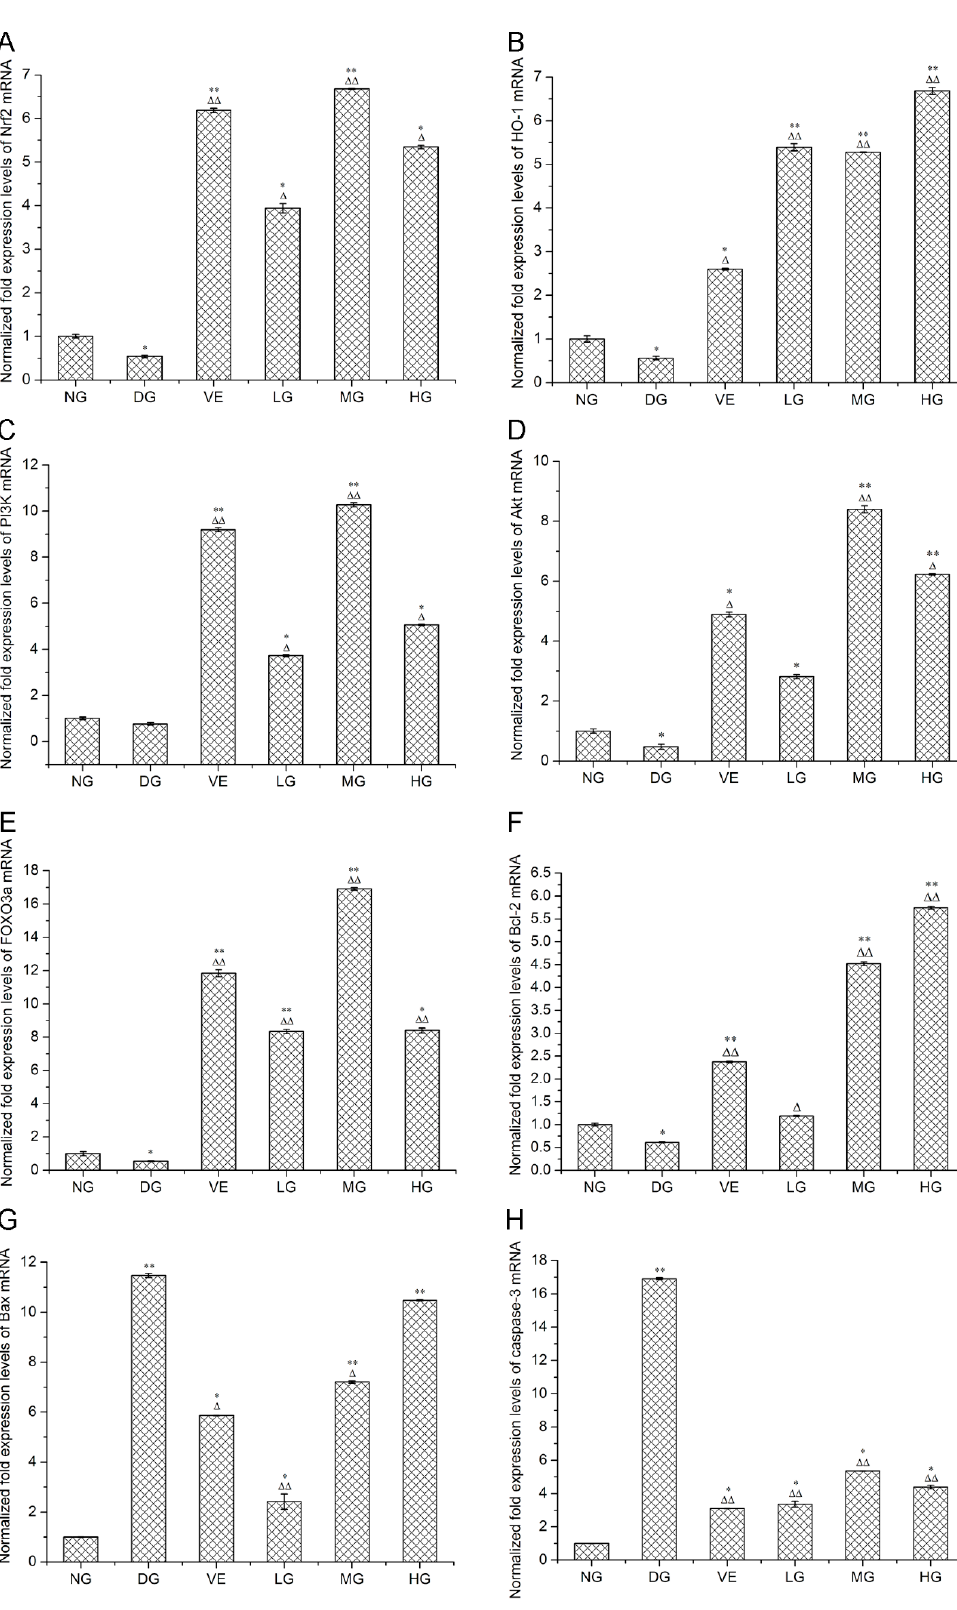
Figure 4. E ff ect of Athyrium multidentatum (Doll.) Ching (AMC) polysaccharides on ( A ) Nrf2 , ( B ) HO-1 , ( C ) PI3K , ( D ) Akt , ( E ) FOXO3a , ( F ) Bcl-2 , ( G ) Bax , ( H ) caspase-3 gene expression in mouse liver (n = 6). * p < 0.05, ** p < 0.01, compared with the normal group (NG); ∆ p < 0.05, ∆∆ p < 0.01, compared with the model group